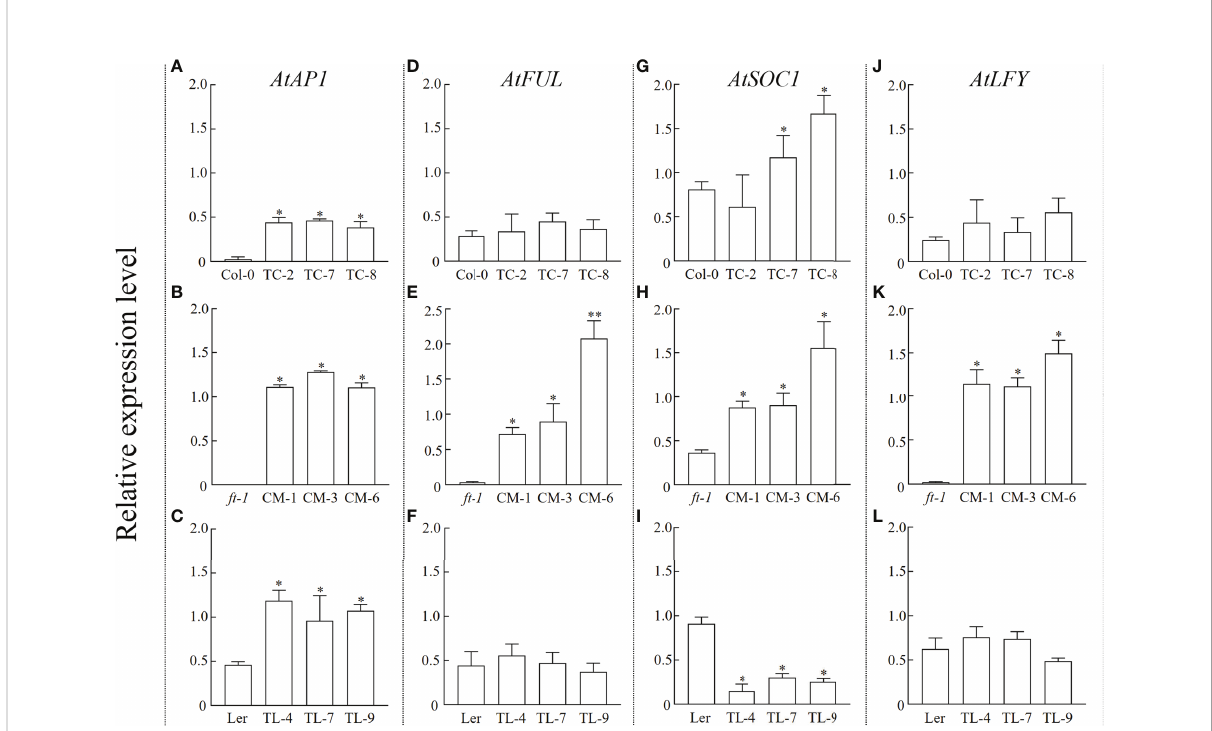
FIGURE 8 Relative expression level of endogenous fl owering related genes in Arabidopsis . Expression levels of AtAP1, AtFUL, AtSOC1, and AtLFY in Col-0 and TC lines (A, D, G, J) , ft-1 and CM lines (B, E, H, K), Ler and TL lines (C, F, I, L), respectively * means p <